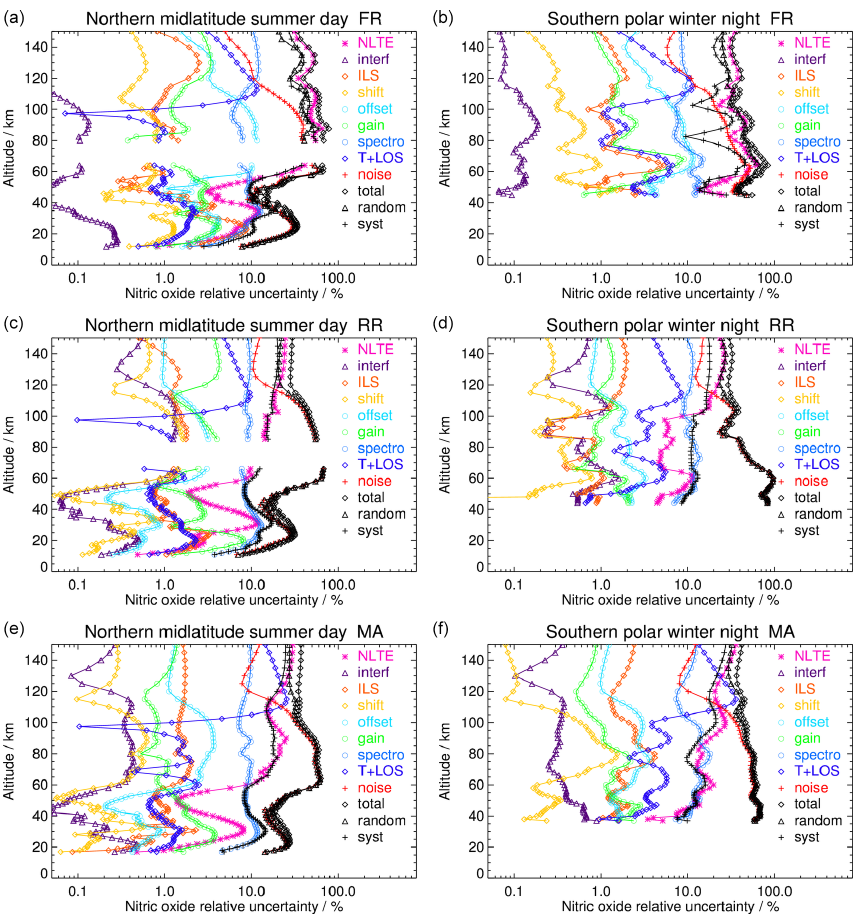
Figure 5. NO error budget for (top to bottom) NOM FR, NOM RR, and MA data for (a, c, e) a northern midlatitude summer day and (b, d, f) southern polar winter night conditions. Additive and multiplicative errors are shown as relative errors in the respective NO vmr profiles. All error estimates are 1 σ uncertainties. Error contributions are marked “T + LOS” for the propagated error from the T + LOS retrieval, “noise” for error due to measurement noise, “spectro” for spectroscopic error, “gain” for gain calibration error (see text), “shift” for spectral shift error (see text), “ILS” for instrument line-shape error (see text), “offset” for error due to spectral offset (see text), “interf” for the error due to interfering gases, and “NLTE” for non-LTE-related